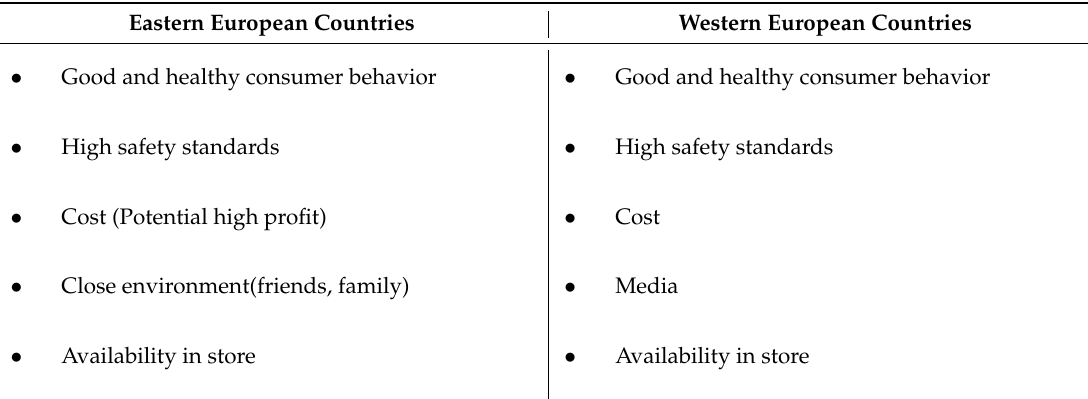
Table 8. Eastern and Western European young adults’